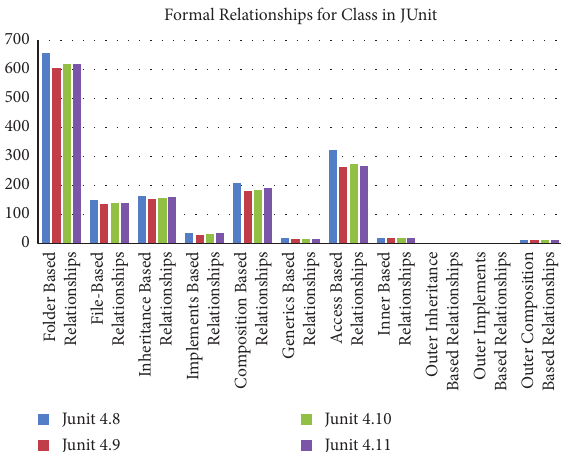
Figure 16: Count of formal relationships for class in